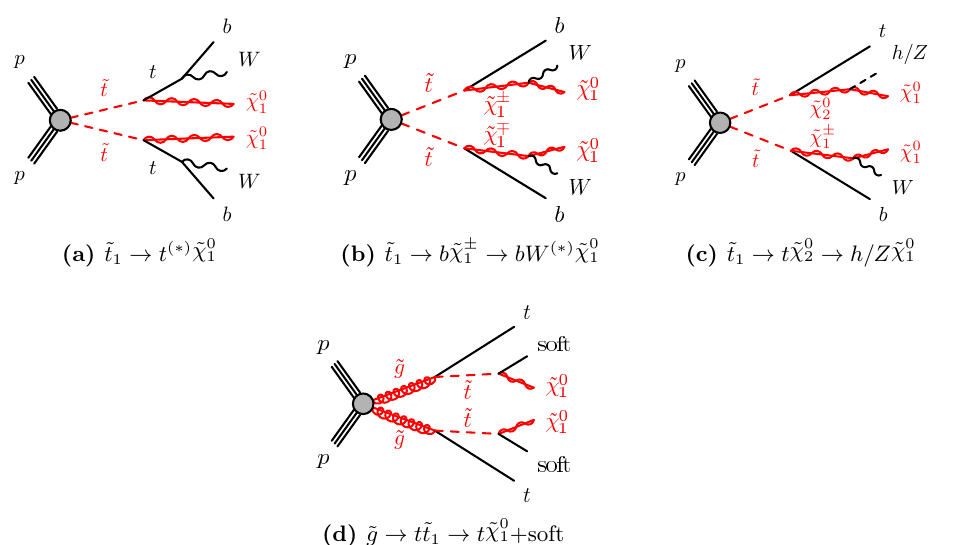
Figure 1. The decay topologies of the signal models considered with experimental signatures of four or more jets plus missing transverse momentum. Decay products that have transverse momenta below detector thresholds are designated by the term